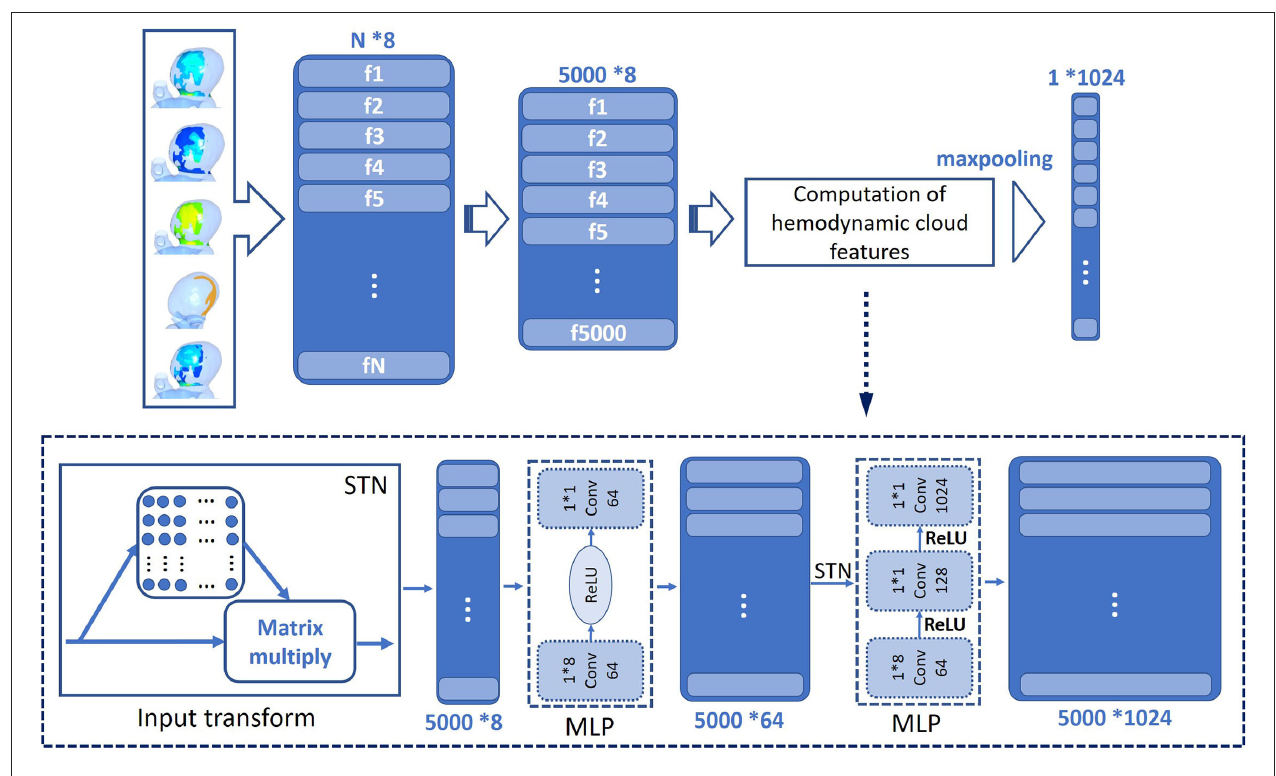
FIGURE 5 | Framework of DL algorithm.